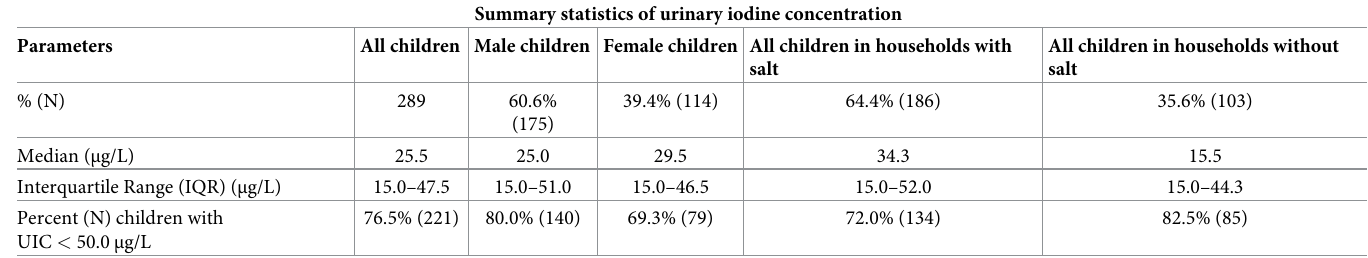
Table 1. Summary statistics of the urinary iodine concentration ( μ g/L) for all the children, for the male and female children and also for all children in households with and without salt.